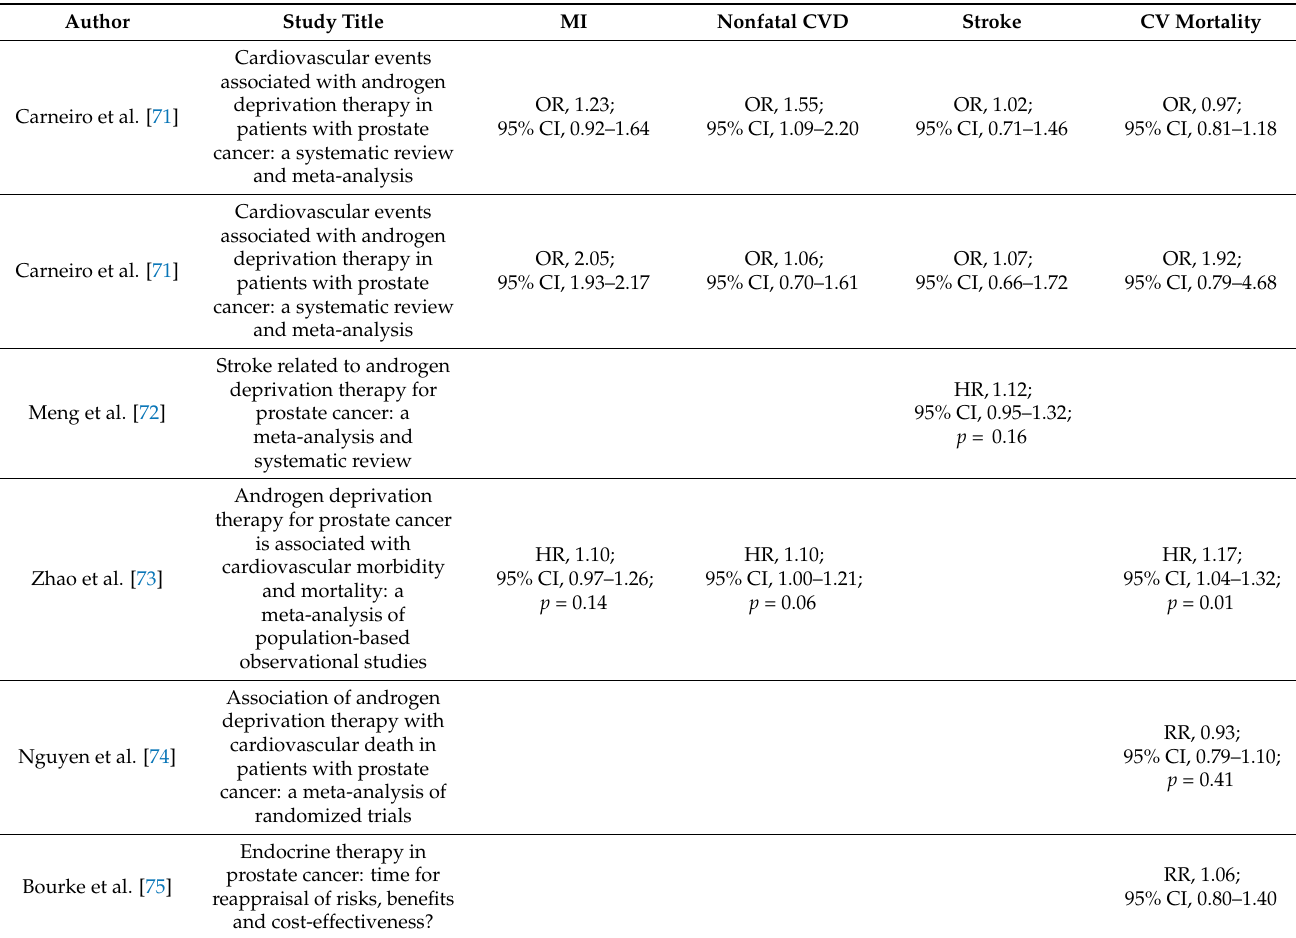
Table A1. CV Adverse Effects in Patients Receiving ADT vs. No ADT.